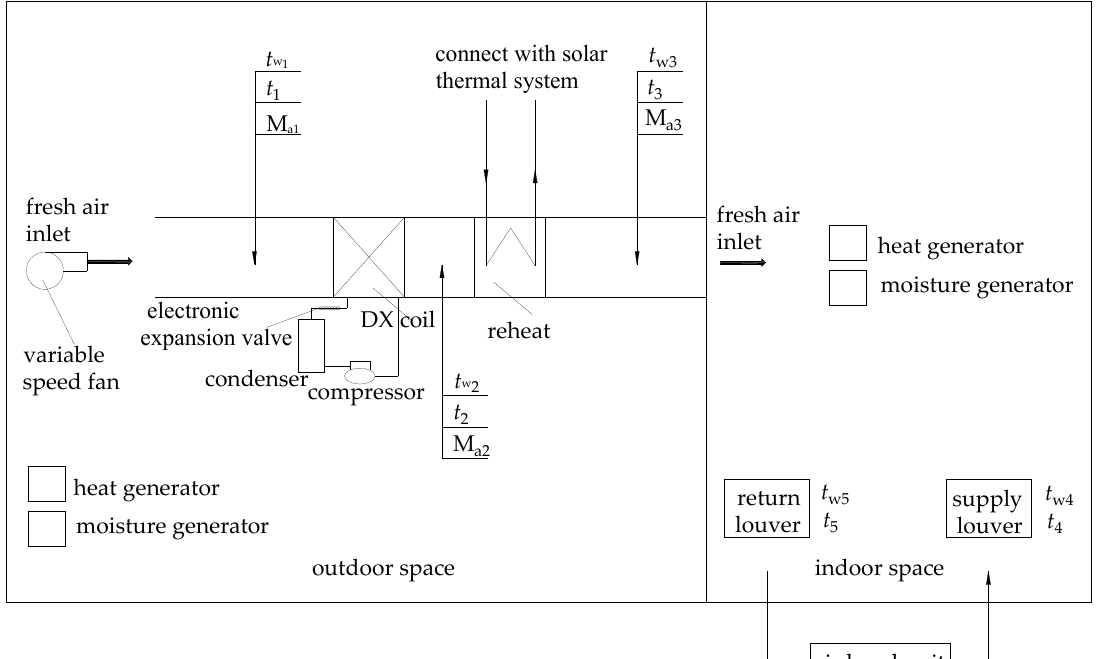
Figure 4. The experimental system.